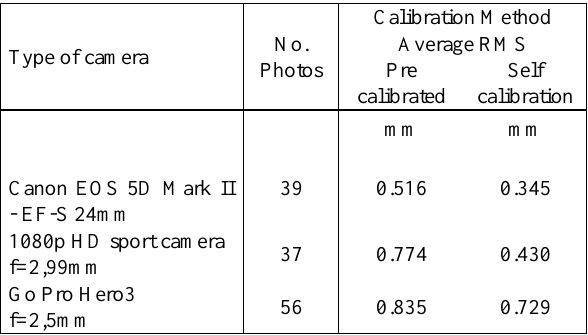
Table 3. Accuracy on targets; values of average RMS obtained with the several cameras